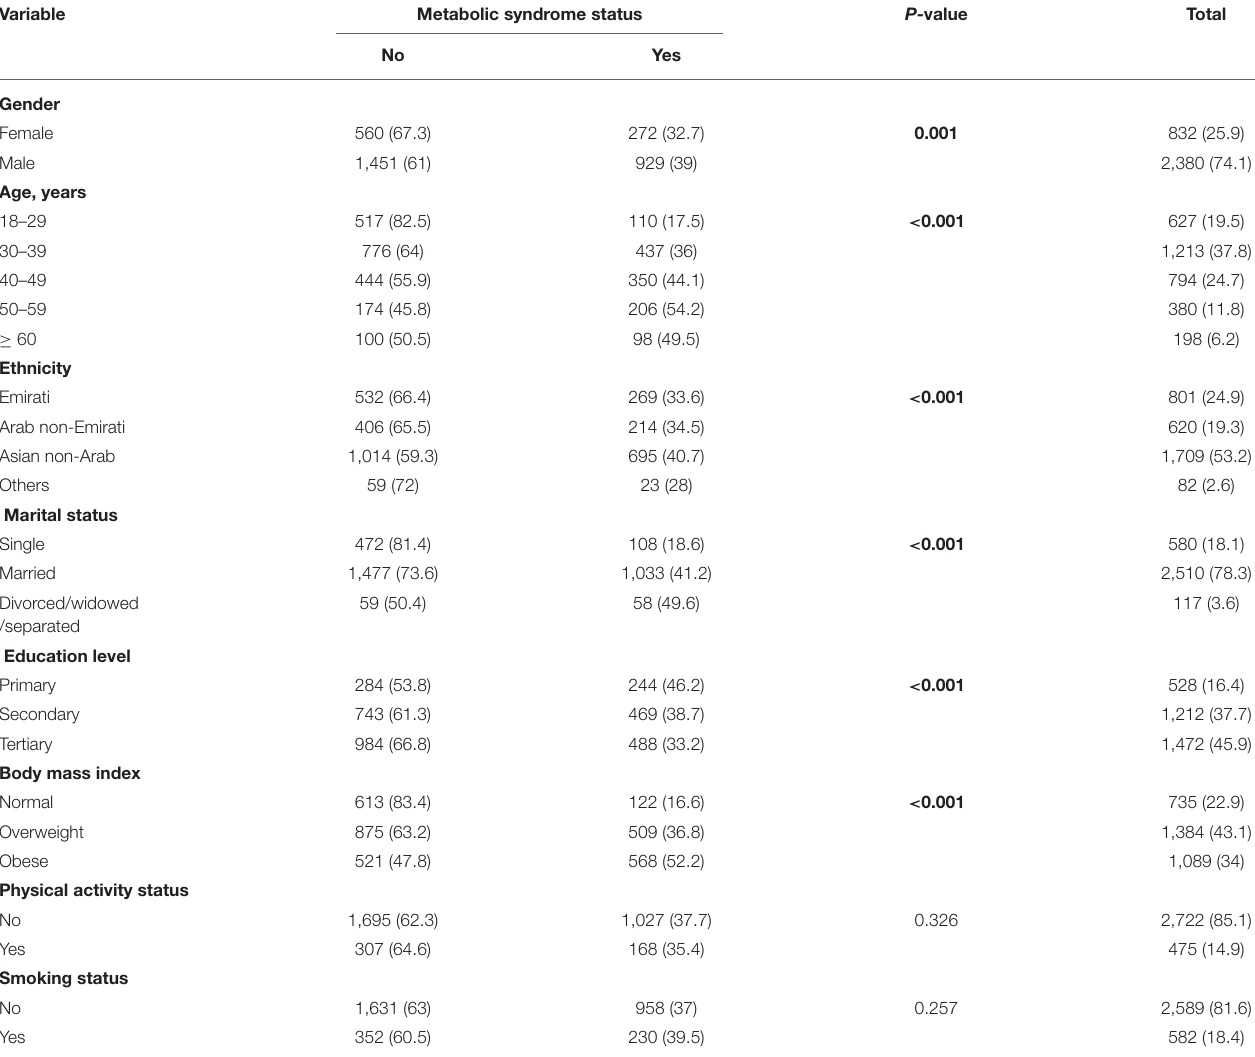
TABLE 2 | Prevalence of the MetS based on the characteristics of the study population, n (%).